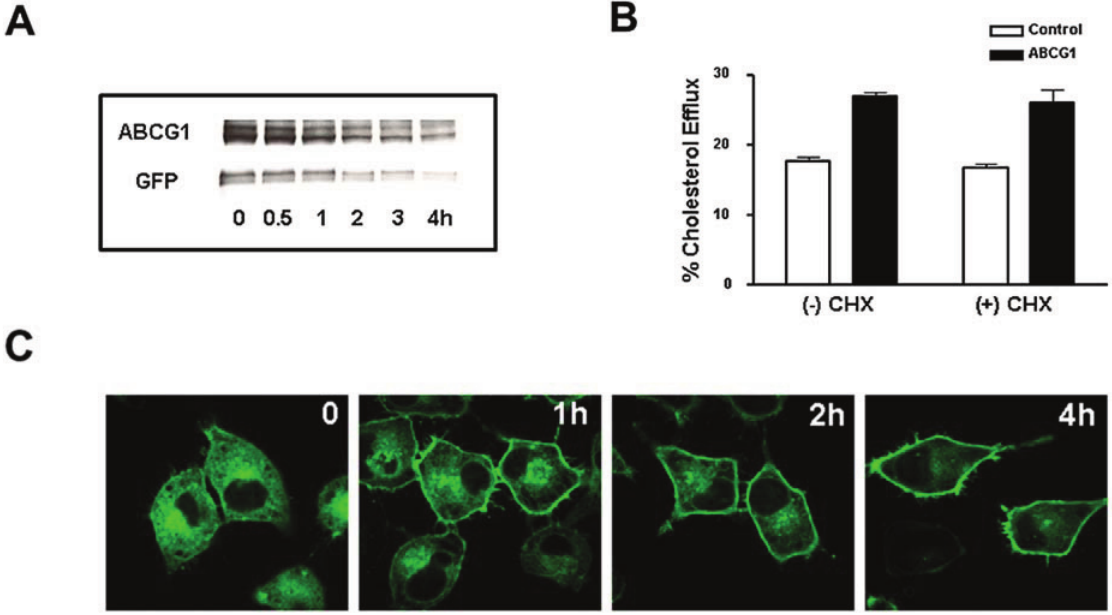
Figure 6. ABCG1-GFP at the cell surface and endosomes mediates cellular cholesterol efflux. ( A ) ABCG1 cells were incubated with 100 μg/mL cycloheximide (CHX) for the indicated times and extracted protein was immunoblotted with antibodies against N